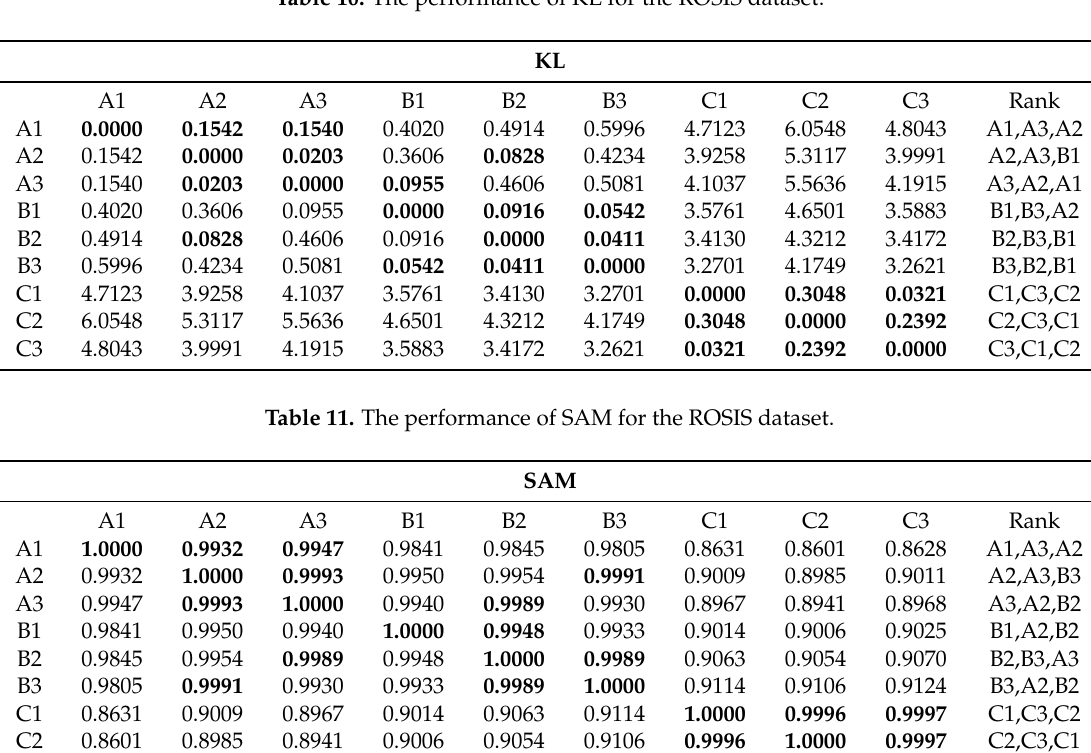
Table 10. The performance of KL for the ROSIS dataset.